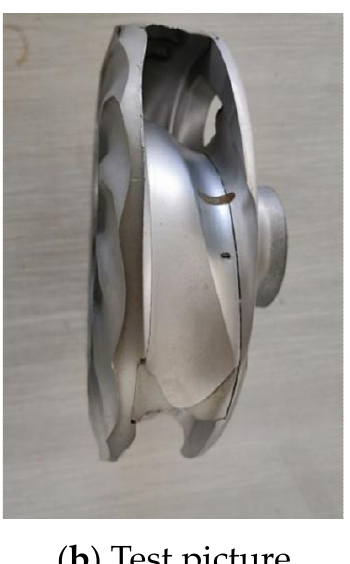
Figure 25. ( a , b ) Comparison of impeller outlet wear.